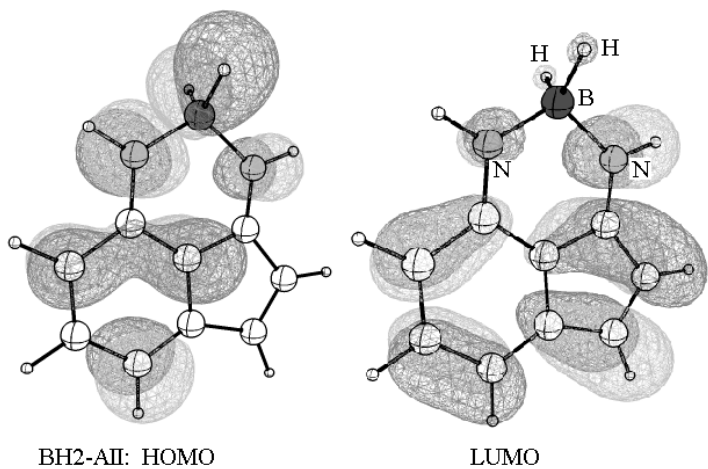
Figure 7. A pictorial representation of the frontier orbitals of BH 2 -AII.